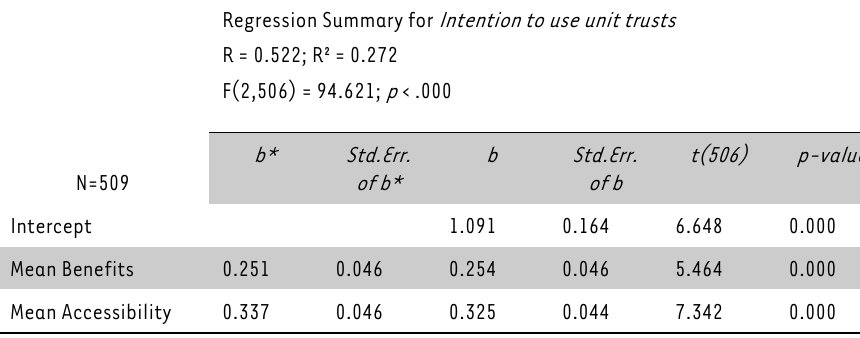
TABLE 5: The influence of Benefits and Accessibility on the Intention to use unit trusts Regression Summary for Intention to use unit trusts R = 0.522; R² = 0.272 F(2,506) = 94.621; p < .000 b* Std.Err. b Std.Err. t(506) p-value N=509 of b* of b Intercept 1.091 0.164 6.648 0.000 Mean Benefits 0.251 0.046 0.254 0.046 5.464 0.000 Mean Accessibility 0.337 0.046 0.325 0.044 7.342